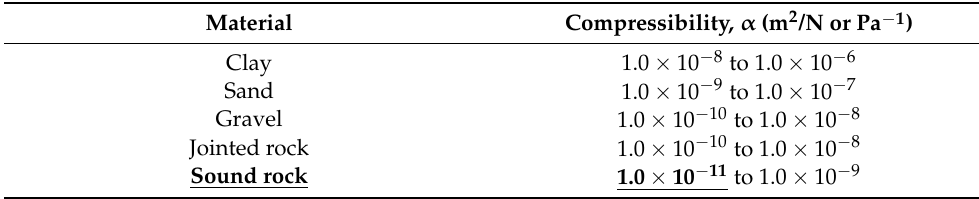
Table 2. Compressibility for different aquifer materials